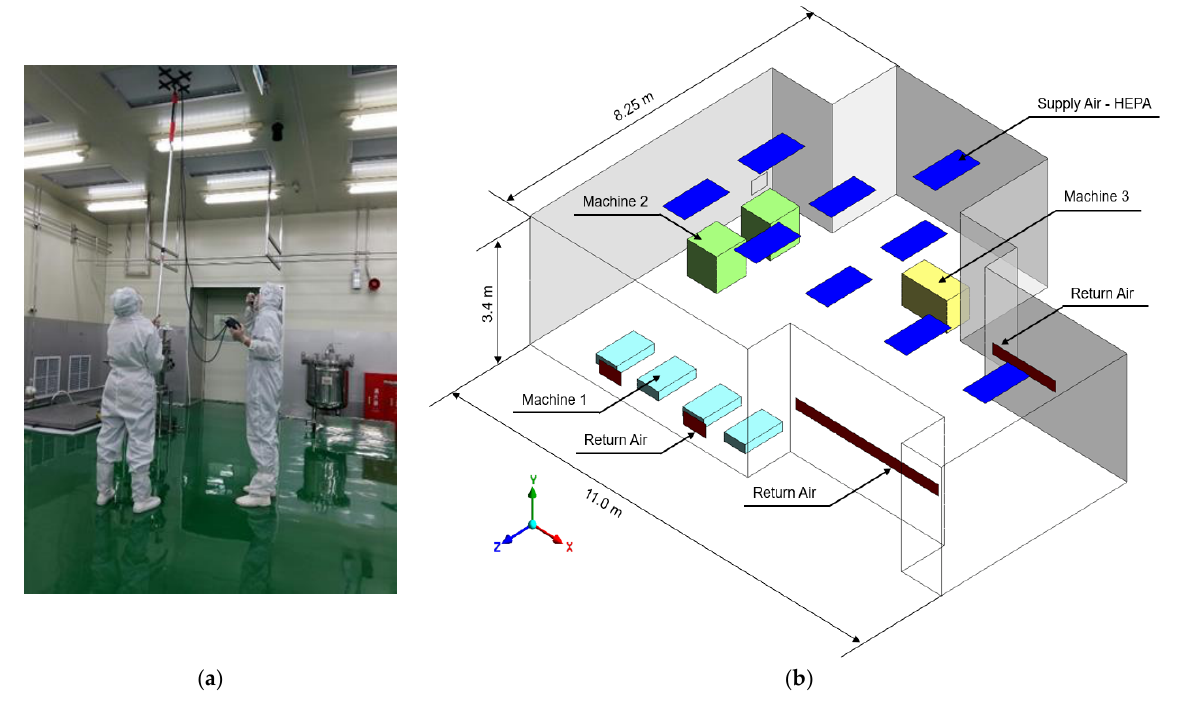
Figure 1. The investigated biotech cleanroom: ( a ) snapshot; ( b ) geometry model.